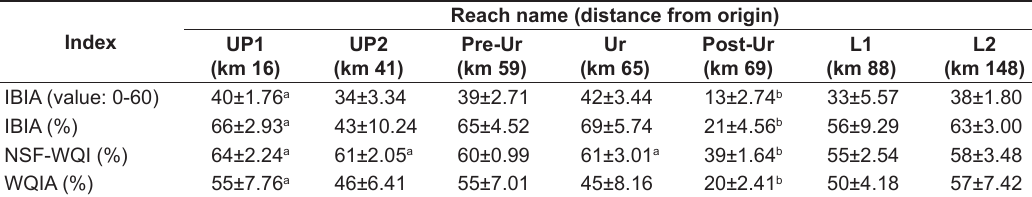
Figure 2. IBIA, WQIA and NSF-WQI scores at seven reaches along the Del Azul stream. Reaches are arranged by their distance from the stream origin. Error bars represent the standard error of the mean. Lines connect scores belonging to the same type of index and do not imply intermediate values. Please refer to the main text for reach acronyms meaning. Table 3. Indexes scores (mean±SE) at the sampled reaches along the Del Azul stream. Different superscript letters indicate significant differences (p<0.05) in mean index value between reaches. Please refer to the main text for reach acronyms